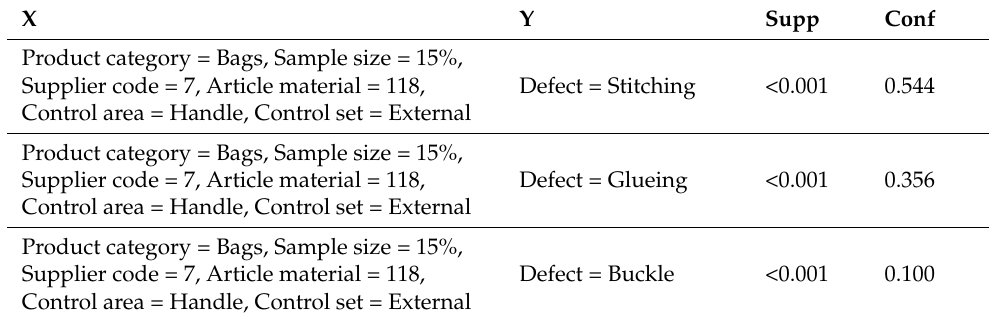
Table 6. Examples of the rules in the form of supplier code, sample size, product category, article material, control area, control set, and